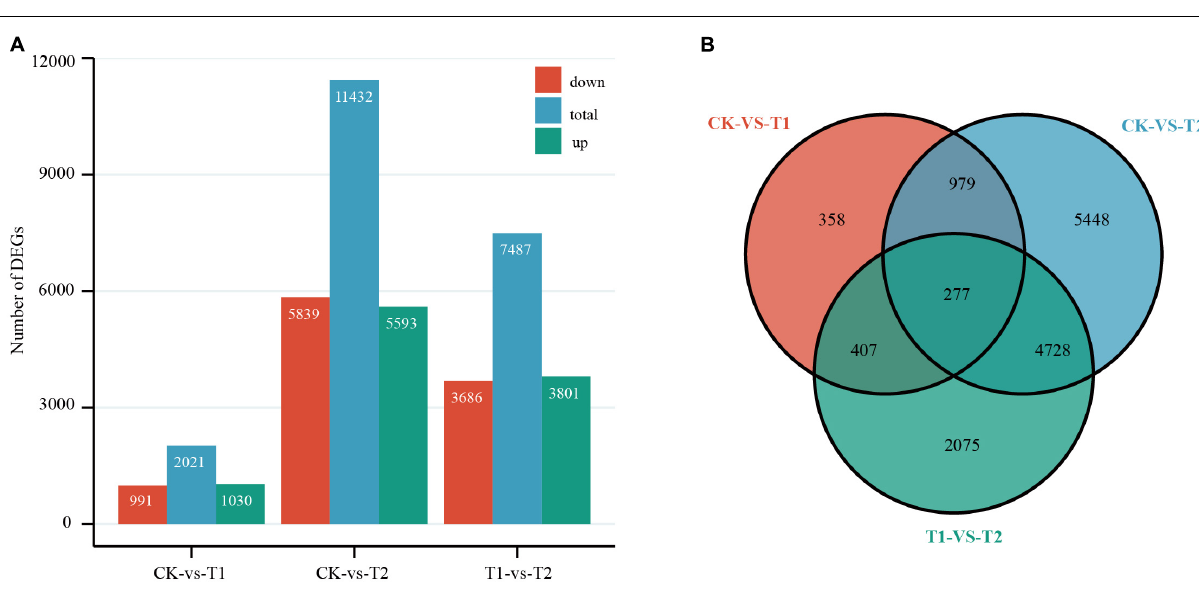
transduction pathway ( Figure 5A ), ABA receptor PYR/PYL was downregulated in T1, while two ( CL2679.Contig1_All and CL2679.Contig2_All ) were upregulated and